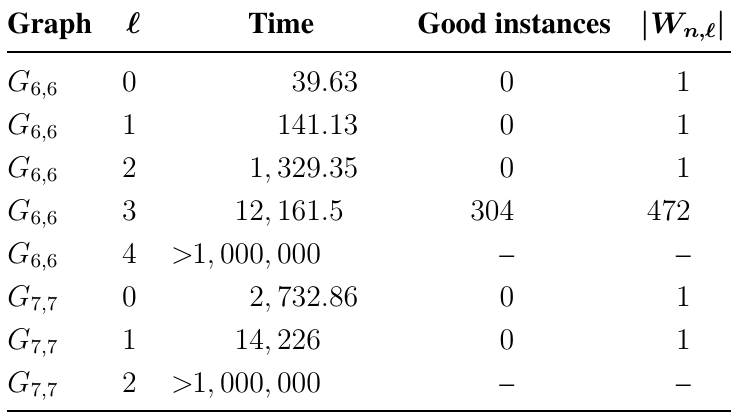
Table 7. Running time, the number of good instances with at most ℓ pairs of numbers, and that of ZDD nodes of W